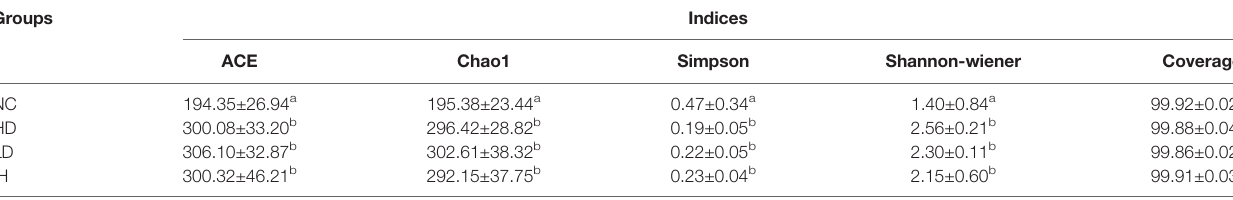
TABLE 3 | Effects of supplementary 1% and 2% of CLNT on microbial alpha diversity in the intestine of IHNV-infected rainbow trout.